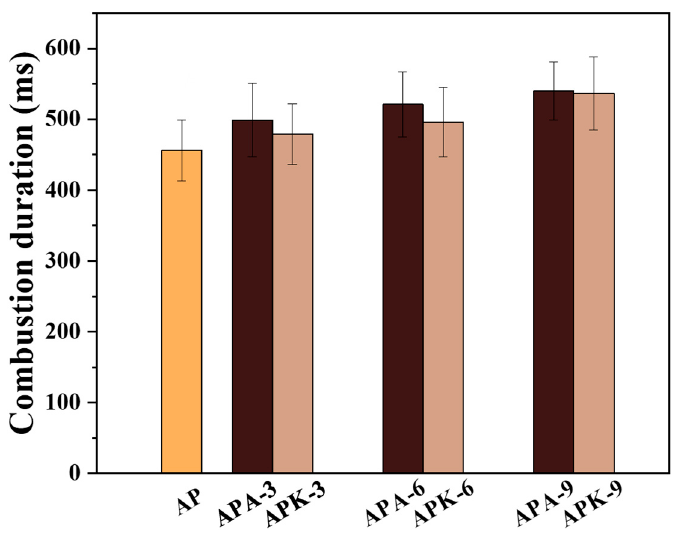
Figure 8. Continuous burning time of each sample on Ni ‐ Cr wire igniter.